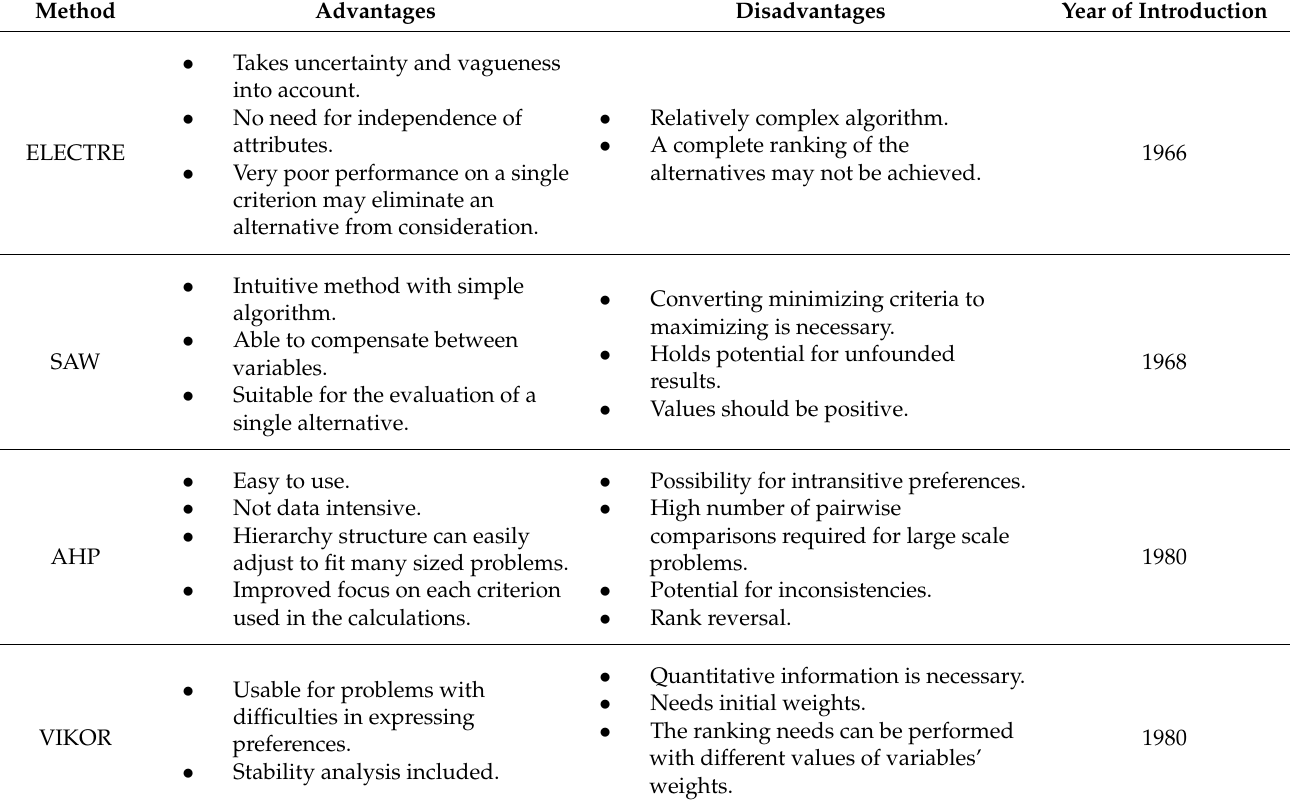
Table 1. Short assessment of various methods used in MCDM.